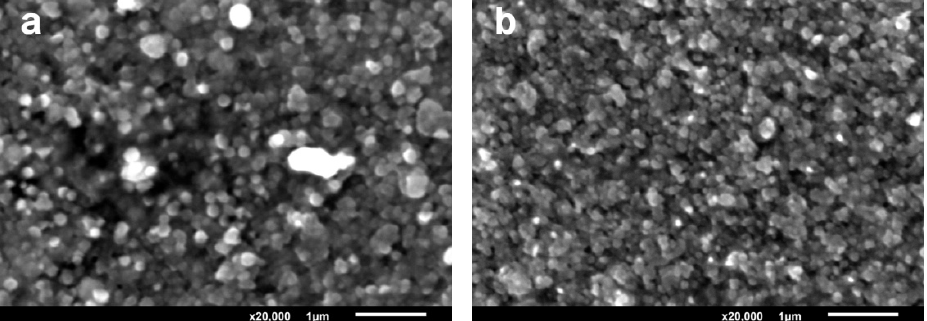
Figure 2. Micrographs of ZnS films electrodeposited at different temperatures: ( a ) T = 70 ° С ; ( b ) T = 30 ° С .